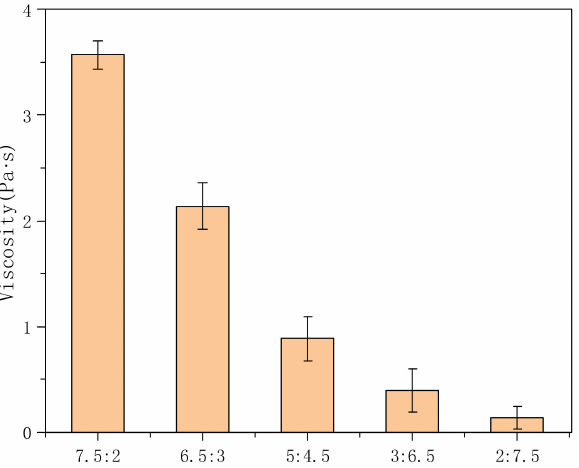
Figure 5. Effects of different monomer ratios on the viscosity of PVA-AA-t aqueous solution (concen- tration: 0.3%; TAC = 0.2 phr).